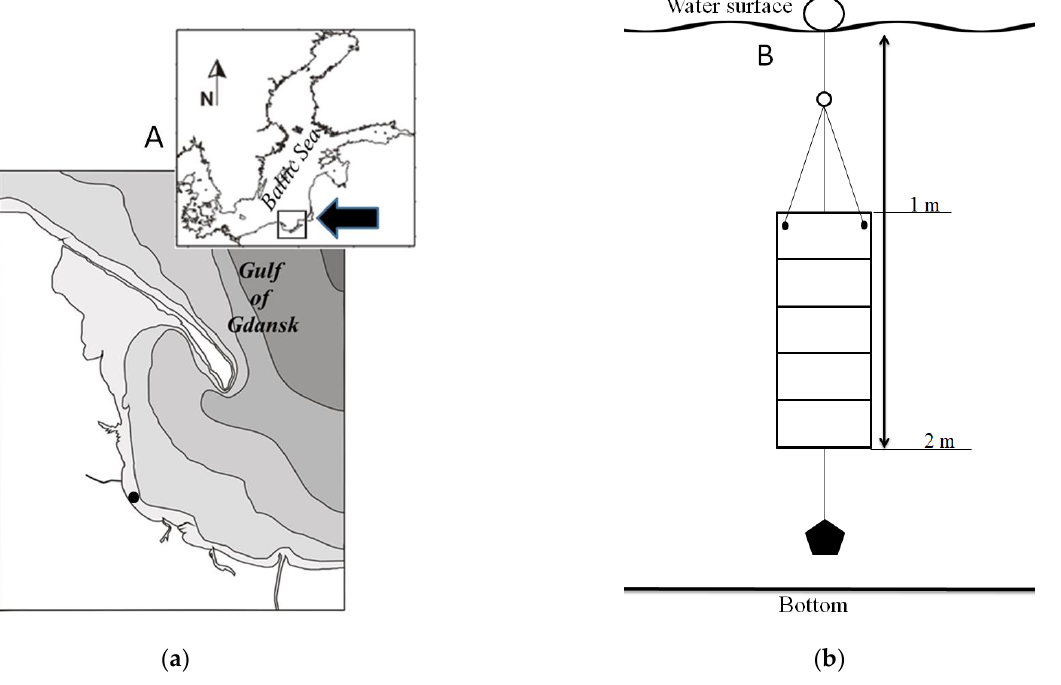
Figure 1. ( a ) Sampling site. The black dot indicates the location of the culture panel during exposure in the Gulf of Gdańsk (54°26′ 51 ″ N 18°34 ′ 33 ″ E). ( b ) The design of the culture panel used in this